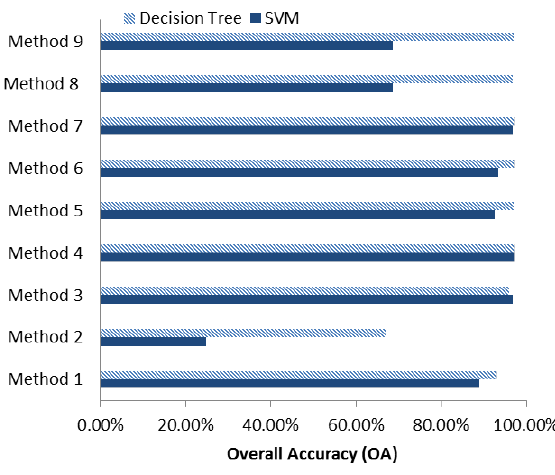
Figure 5. Performance of different methods using SVM and decision tree.